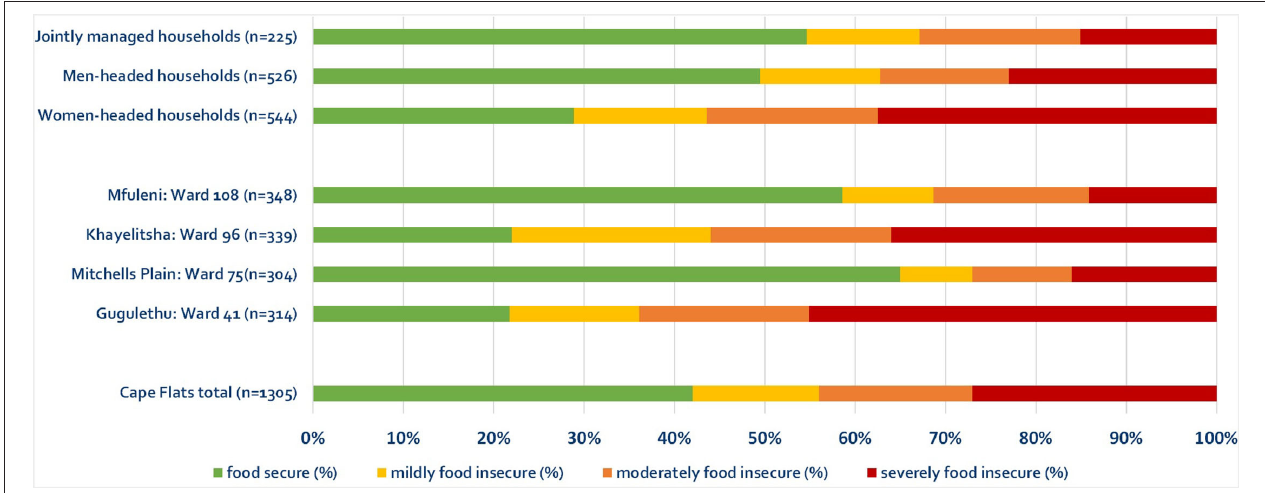
FIGURE 1 | Food Insecurity Experience Scale (FIES) rating of four communities in the Cape Flats in September 2020, by gender of household head and location.